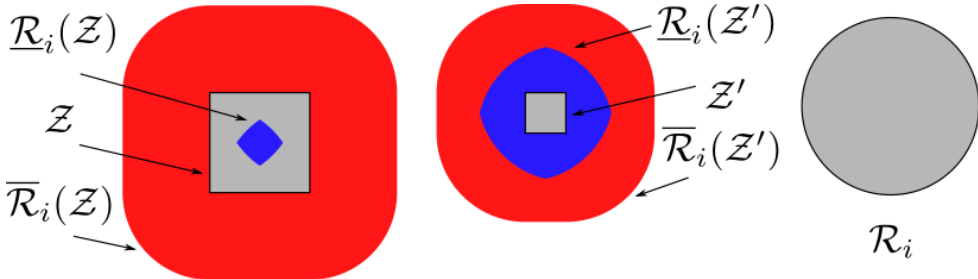
Figure 2. Over-approximation R i ( Z ) (resp., R i ( Z (cid:48) )) and under-approximation R i ( Z ) (resp., R i ( Z (cid:48) )) of the footprint of robot i when swept over Z ⊂ R 2 (resp., Z